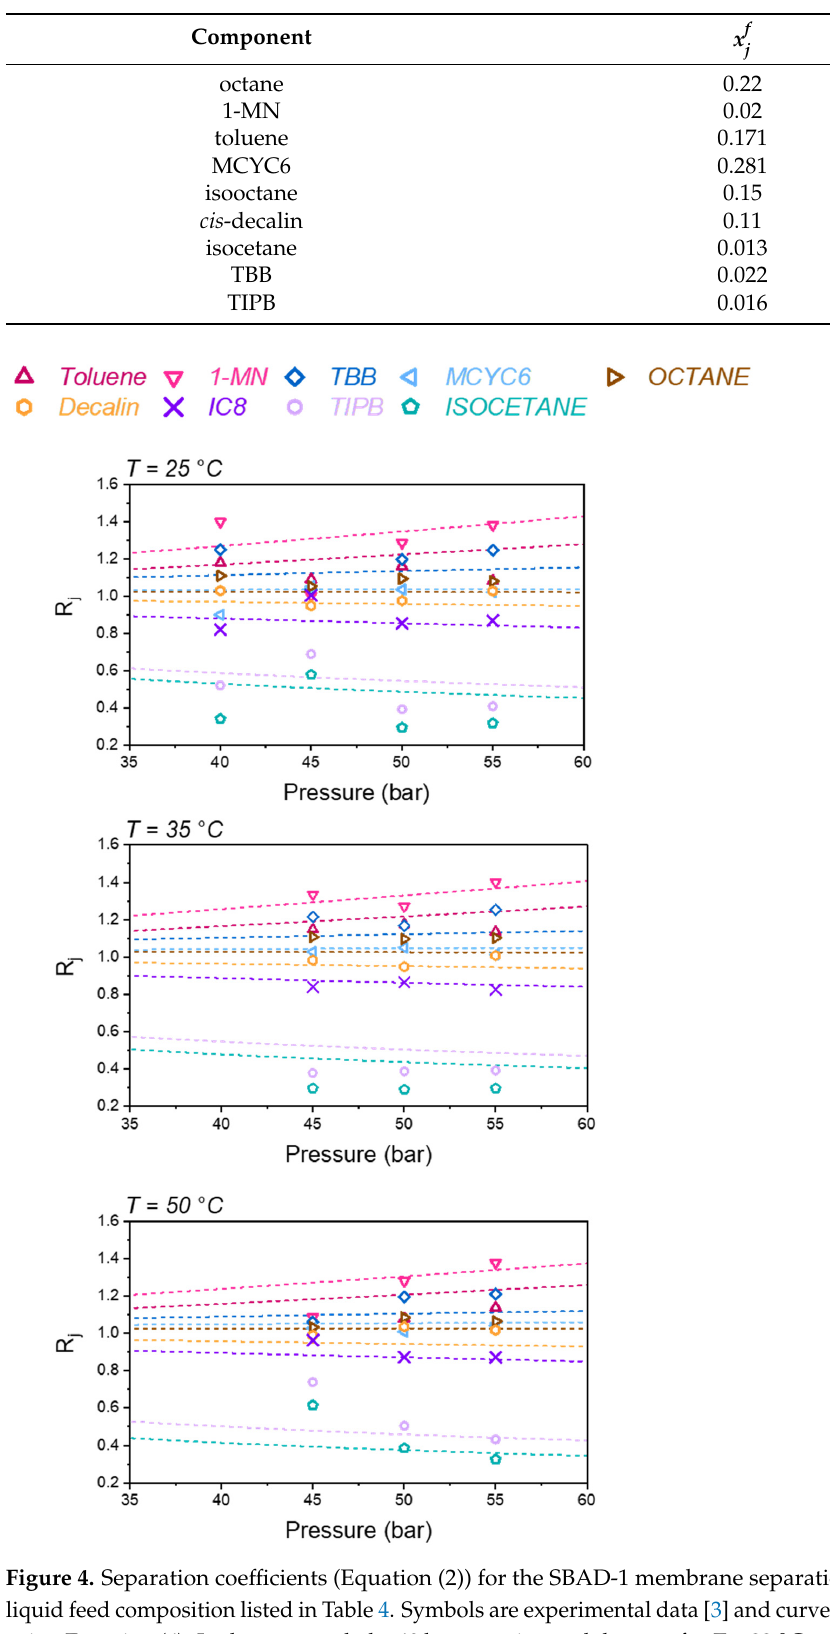
Table 4. Nine-component mixture for SBAD-1 membrane separation from Thompson et al. [3].